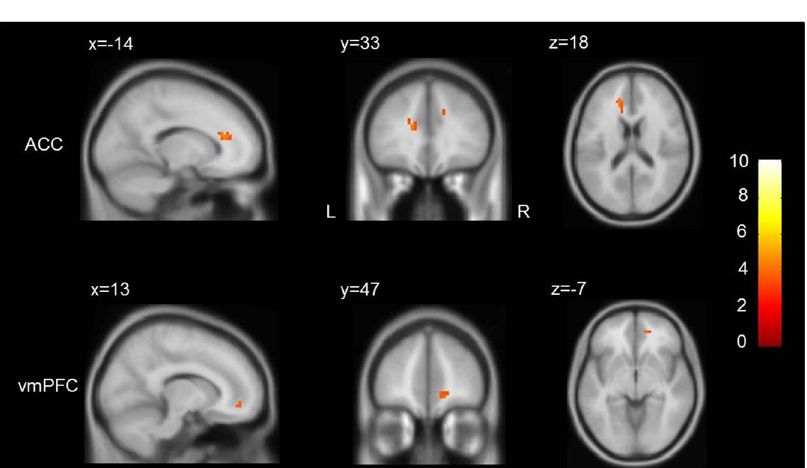
Figure 6. Regions showing reduced psychophysiological interaction (PPI) with right IFG during negative versus neutral stimuli evaluation in adolescents with GAD compared with HCs. The threshold was set at p < 0.001 (uncorrected). Color bar denotes t value. x, y, z denote MNI (Montreal Neurological Institute) coordinates. IFG = inferior frontal gyrus, ACC = anterior cingulate cortex, vmPFC = ventromedial prefrontal cortex, GAD = generalized anxiety disorder, HCs = healthy controls, L = left, and R =